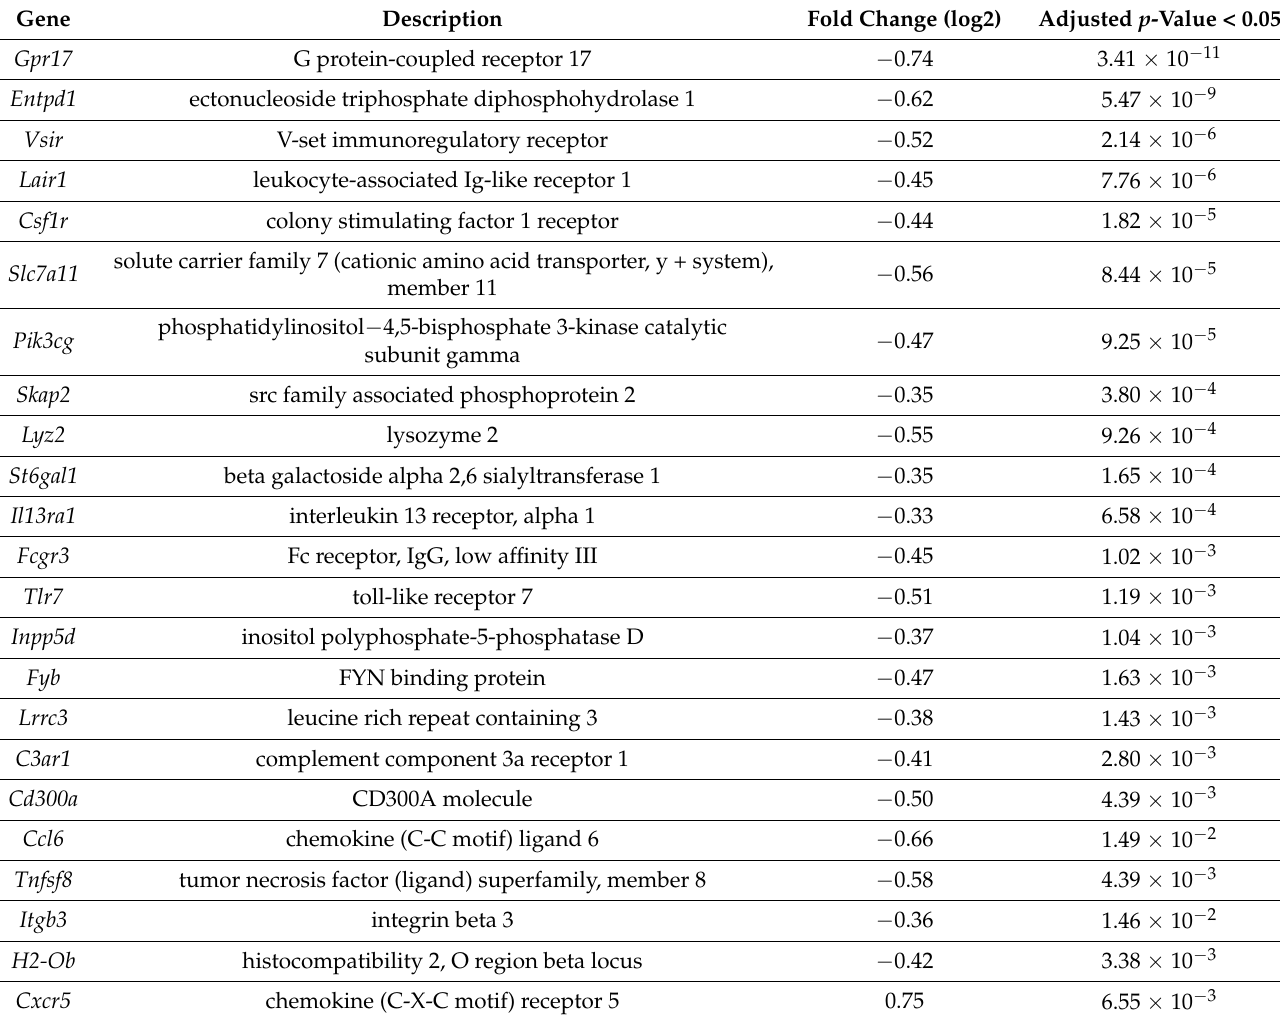
Table 3. Significantly differentially expressed genes related to microglia and innate